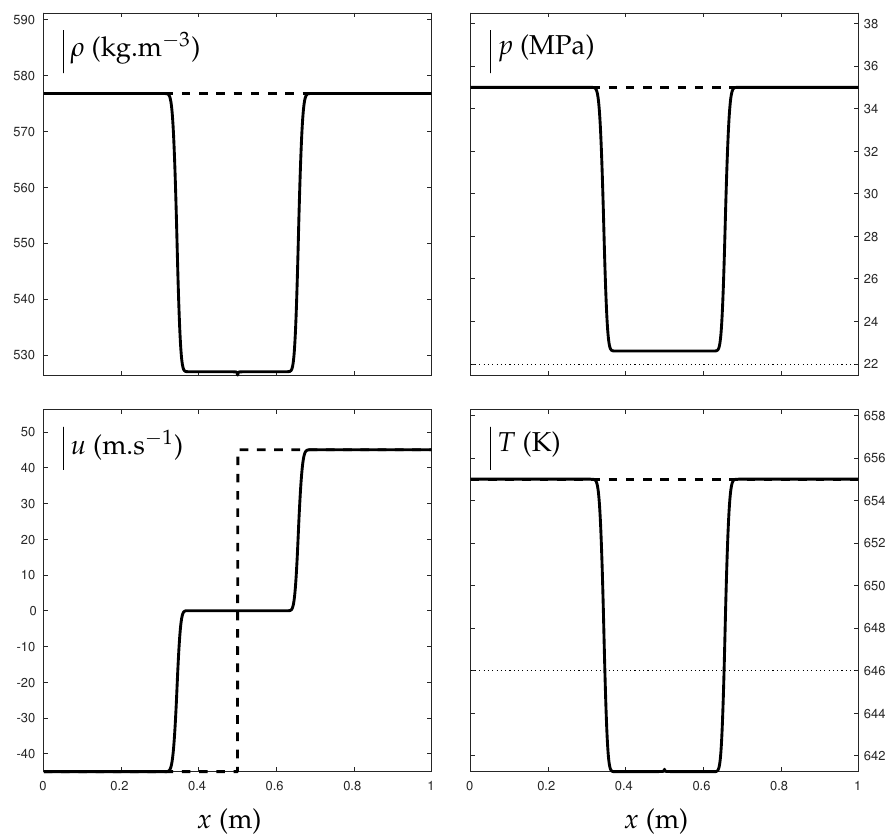
Figure 11. Double expansion test illustrating the transition from supercritical state to “pure” liquid water. The critical pressure and temperature are indicated with the dotted lines. The thick lines represent the solution obtained with the mixture ENASG EOS. The dashed lines represent the initial = 1 = Y = 10 − 6 , conditions. Liquid water is initially in major proportions with Y 2 10 − 6 , Y 2 3 1 − × ± 45 m/s. The test was carried out with a Godunov time integration p = 350 bars, T = 655 K and u = method and HLLC Riemann solver extended to the second order: MUSCL scheme with Minmod flux limiter. The solution is given at t 0.3 ms on a 1000-cell mesh using CFL = 0.8. ≈